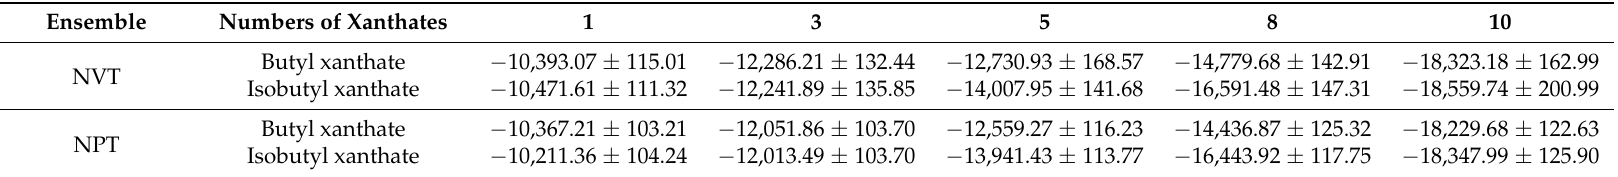
Table 4. Electrostatic energies of different xanthate concentrations in the flotation chemistry for NVT or NPT ensemble